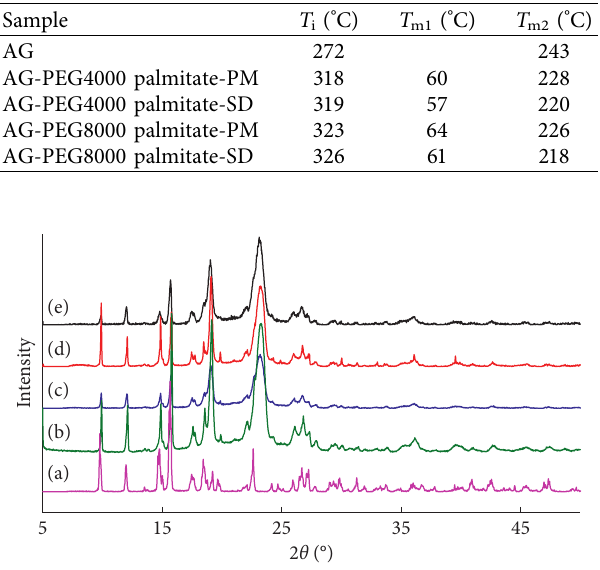
Figure 3: XRD patterns of (a) pure AG, (b) AG-PEG4000 pal- mitate-PM, (c) AG-PEG4000 palmitate-SD, (d) AG-PEG8000 palmitate-PM, and (e) AG-PEG8000 palmitate-SD.